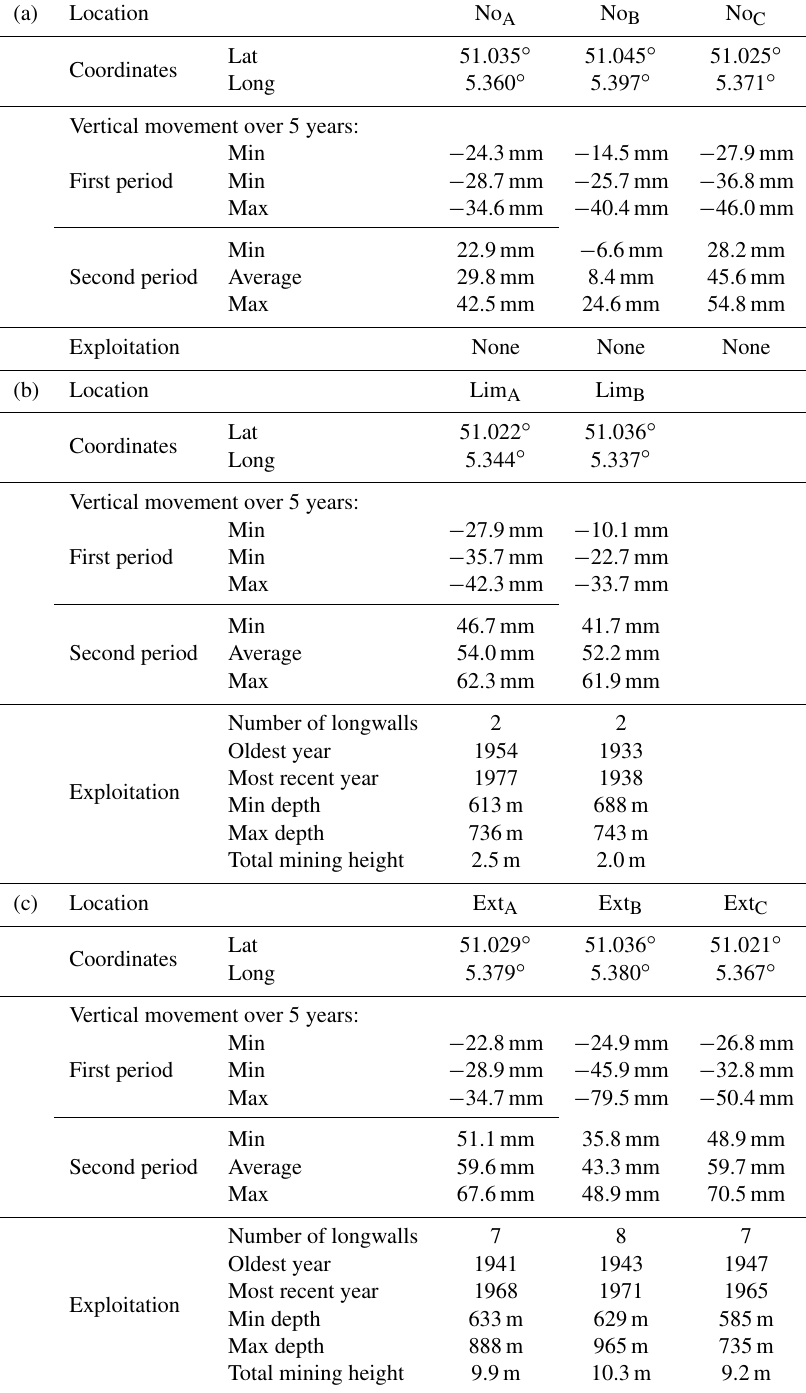
Table 4. Information of selected locations, i.e., movement of 10 reflectors around coordinates given over 5-year time zones in both observation periods and mining characteristics underneath locations: (a) no exploitation, (b) limited exploitation; (c) extensive